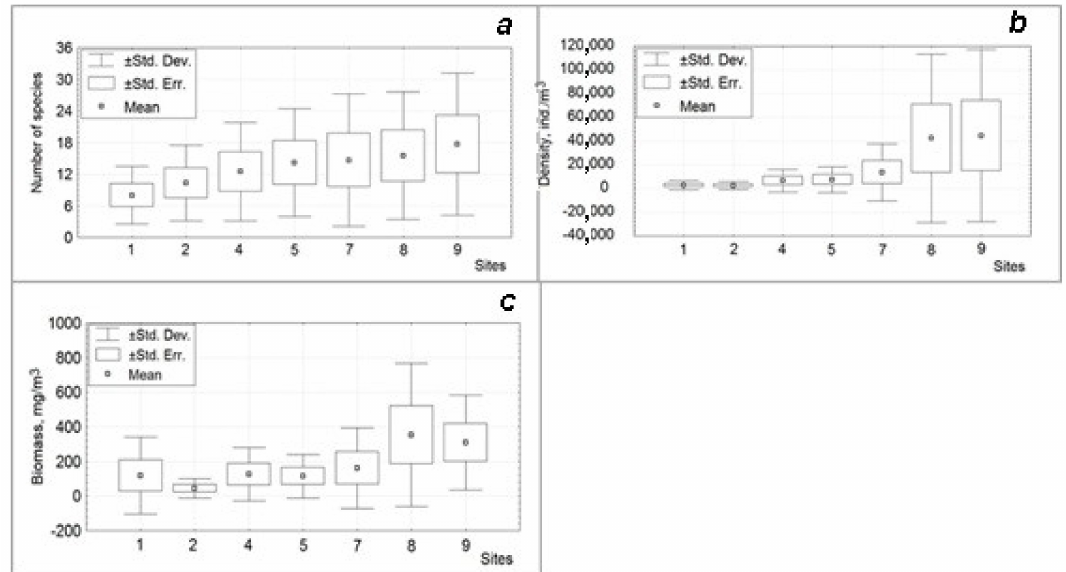
Figure 10. The change in the average long-term species richness ( a ), density ( b ) and biomass ( c ) of zooplankton downstream the main channel of the river (sites numbers correspond to those specified in Table